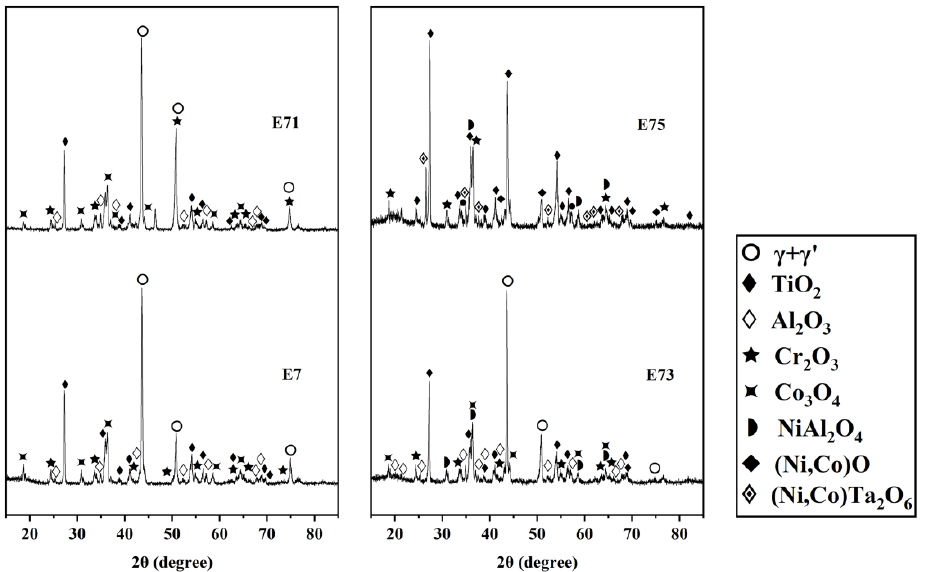
Figure 4. XRD patterns of samples exposed for 100 h at 1000 °C.